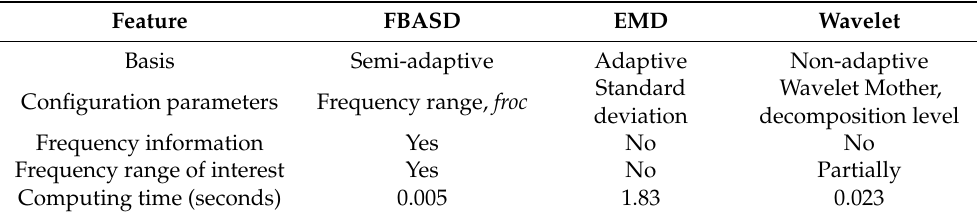
Table 2. Features for the FBASD, EMD, and Wavelet